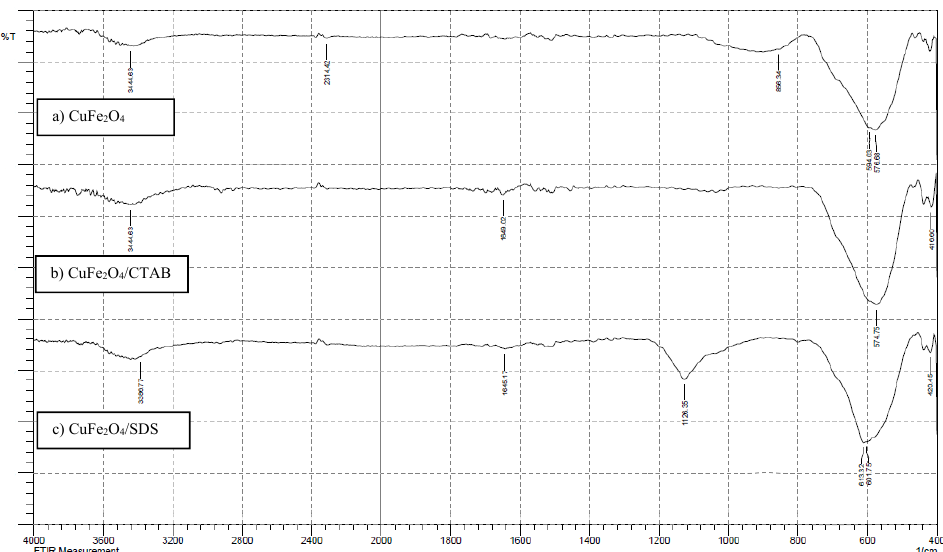
Fig. 3. FT-IR spectra of CuFe